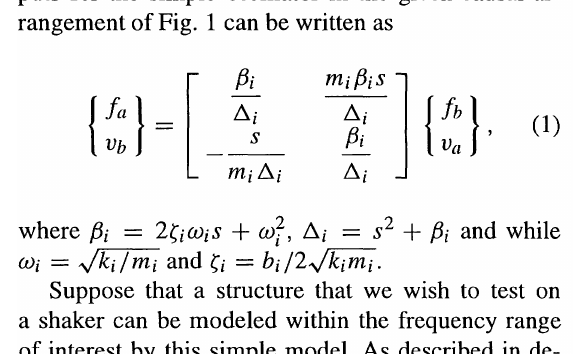
b, respectively. This positive power convention is de noted by the half arrowheads on the respective bonds.